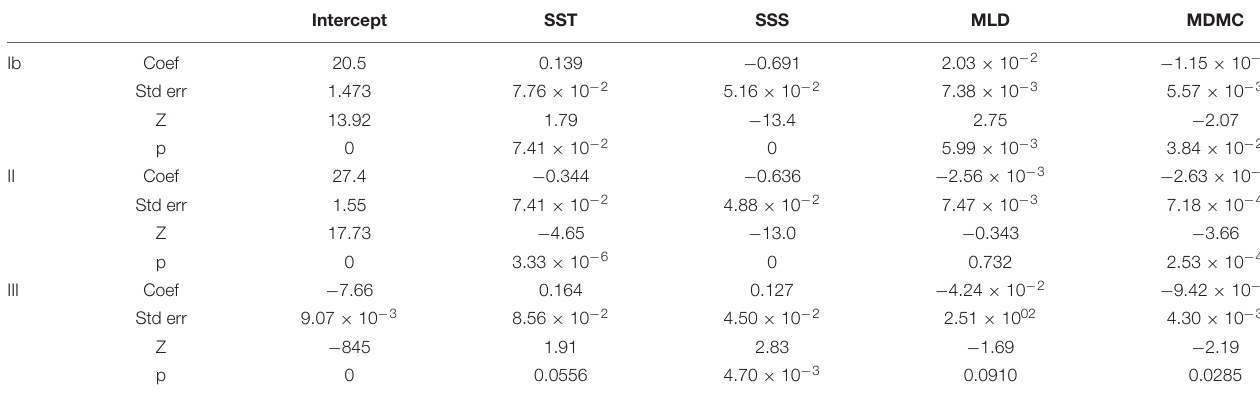
TABLE 5 | Results of multinomial regression for cox haplogroup (rel. to haplogroup I) against reconstructed environmental parameters, for all strains for which cox haplogroup is available (from 1993). Intercept SST SSS MLD